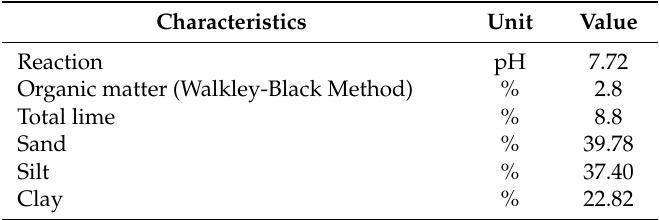
Table 6. Main physical and chemical characteristics of the soil in the study area.